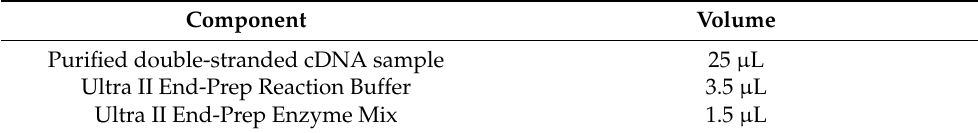
Table 8. End repair and dA-tailing reaction mix.